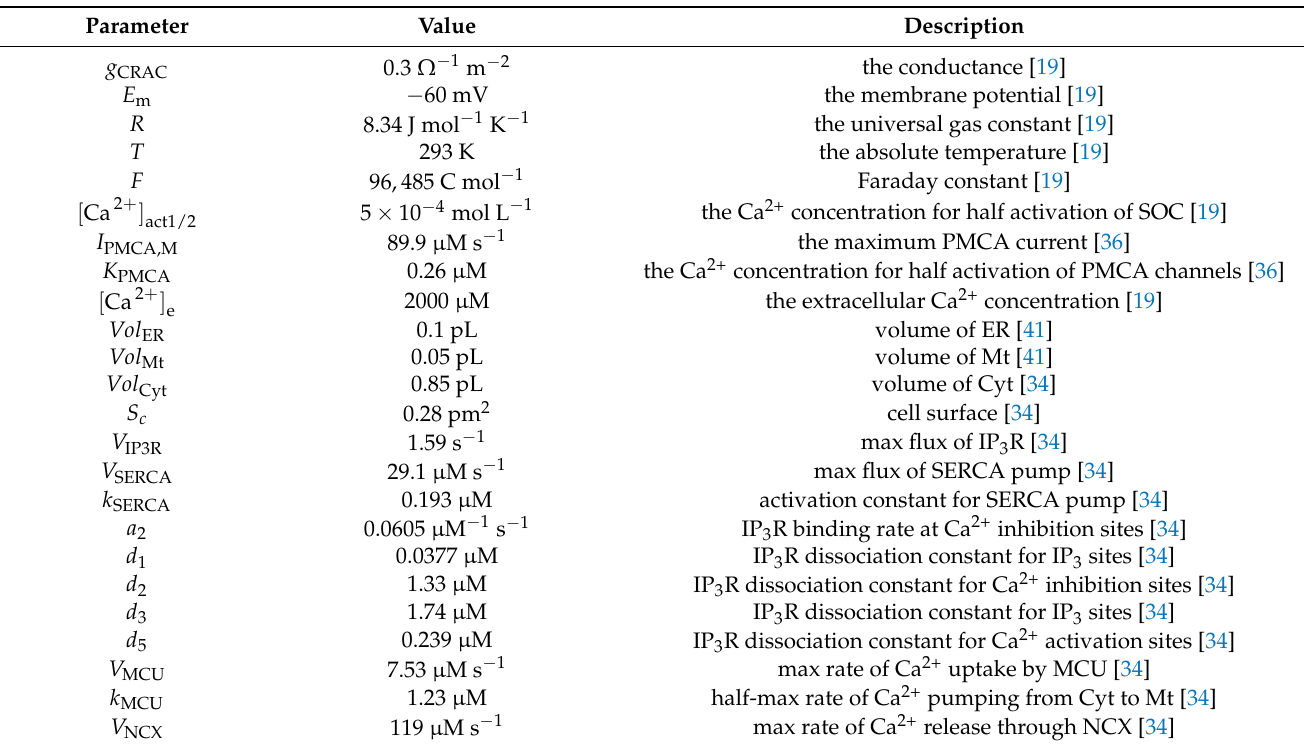
Table 1. Parameters of the